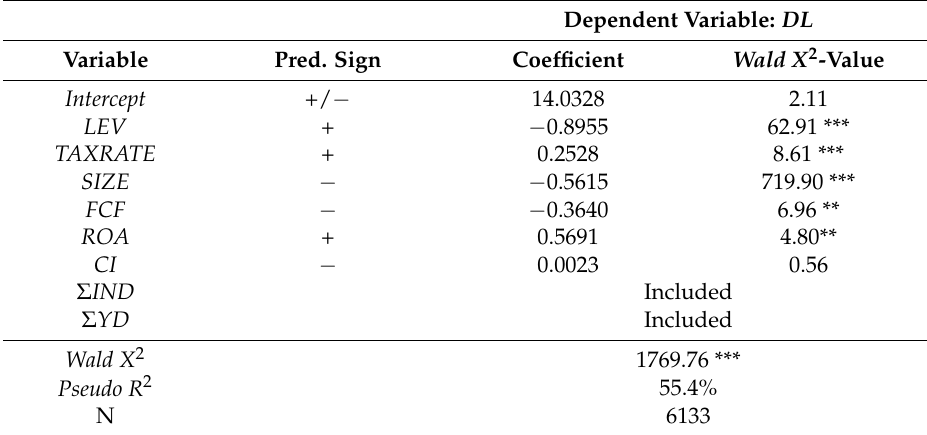
Table 4. 1st Stage Probit Regression